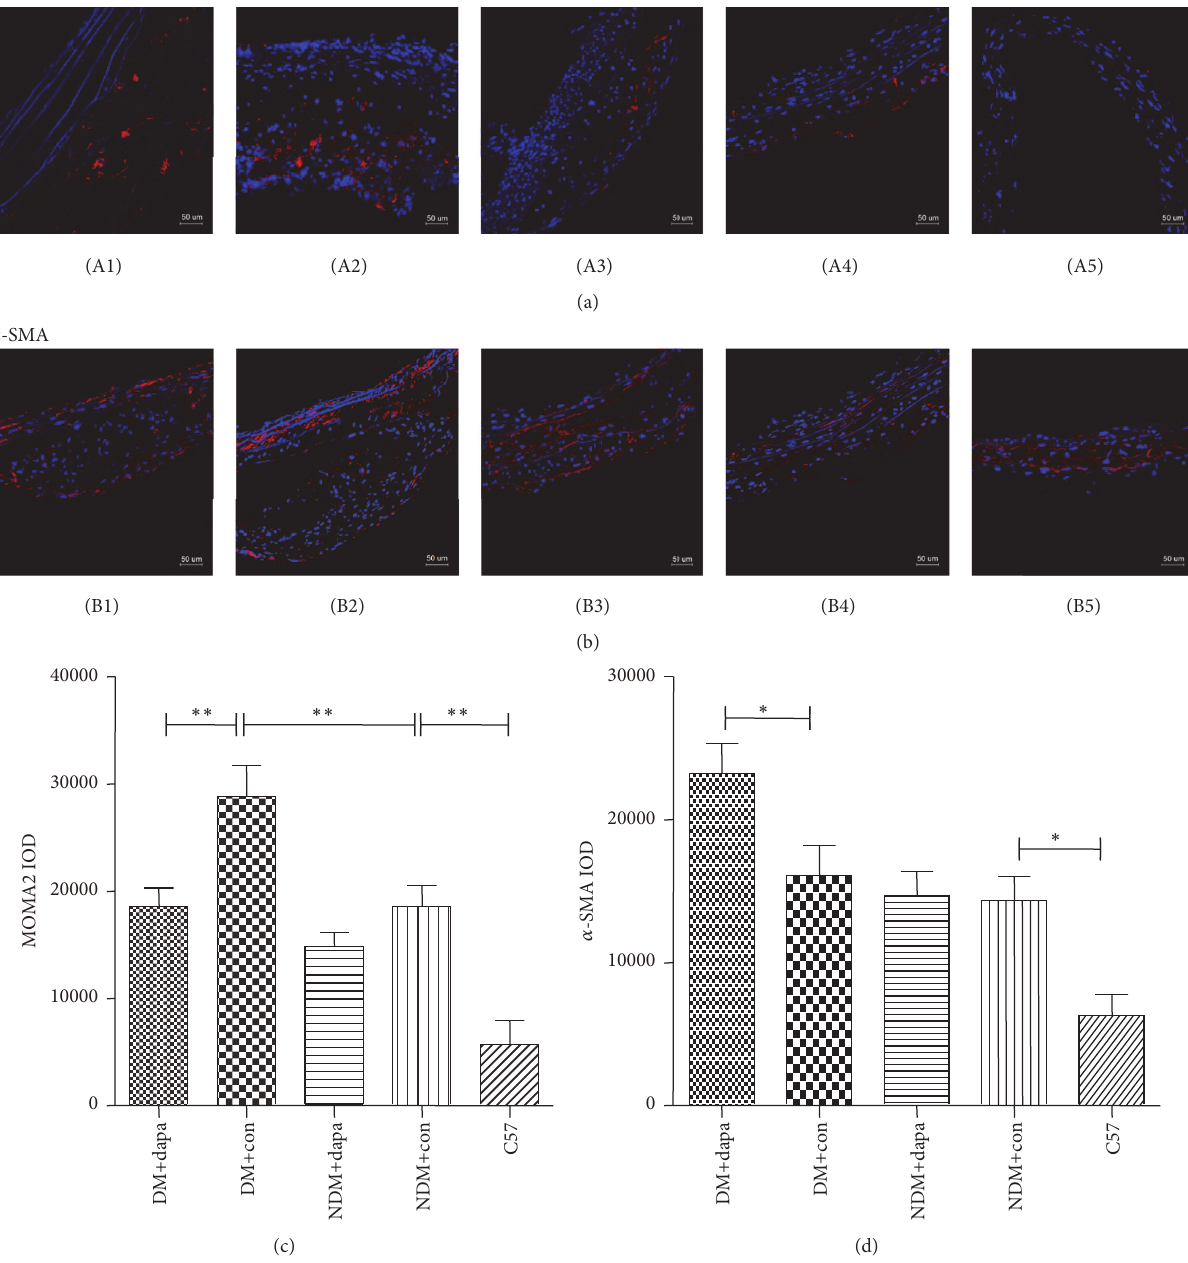
Figure 4: Influence of dapagliflozin on cellular formation (macrophage infiltration and smooth muscle cells) in atherosclerotic lesion in the aorta. Numbers 1–5 indicated diabetic treatment group, diabetic control group, nondiabetic treatment group, nondiabetic control group, and C57BL/6J control group, respectively. (a) Macrophage infiltration in atherosclerotic lesions (red: macrophages; blue: nuclei); (b) smooth muscle cell infiltration in atherosclerotic lesions (red: 𝛼 -SMA antibody labeled smooth muscle cells; blue: DAPI-labeled nuclei); (c) immunofluorescence optimal density of MOMA2 antibody; (d) immunofluorescence optimal density of 𝛼 -SMA antibody. ∗ 𝑝 < 0.05 ; ∗∗ 𝑝 < 0.01